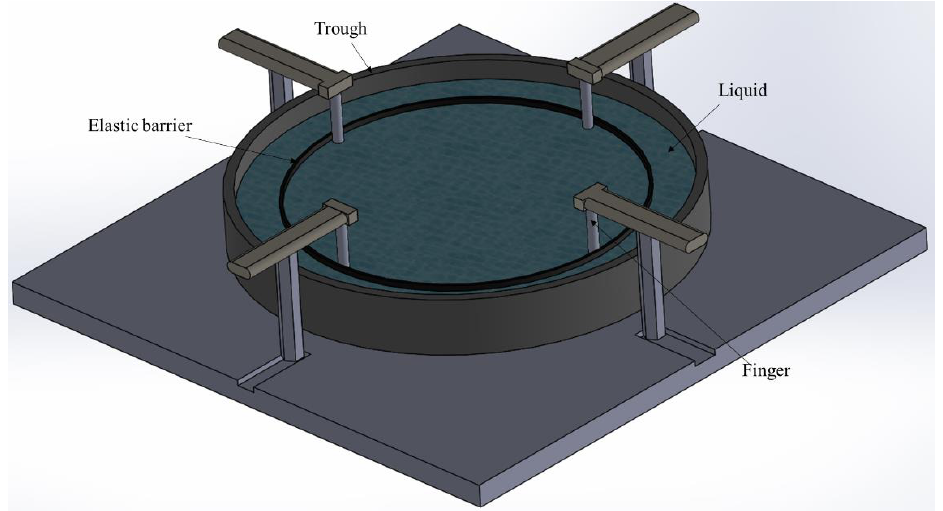
Figure 18. Schematic diagram of the radial trough setup composed of a circular Teflon trough with an elastic barrier and aluminum fingers, controlled by a stepper motor. Adapted from Ref. [27]. Copyright 1855 Taylor and Francis.